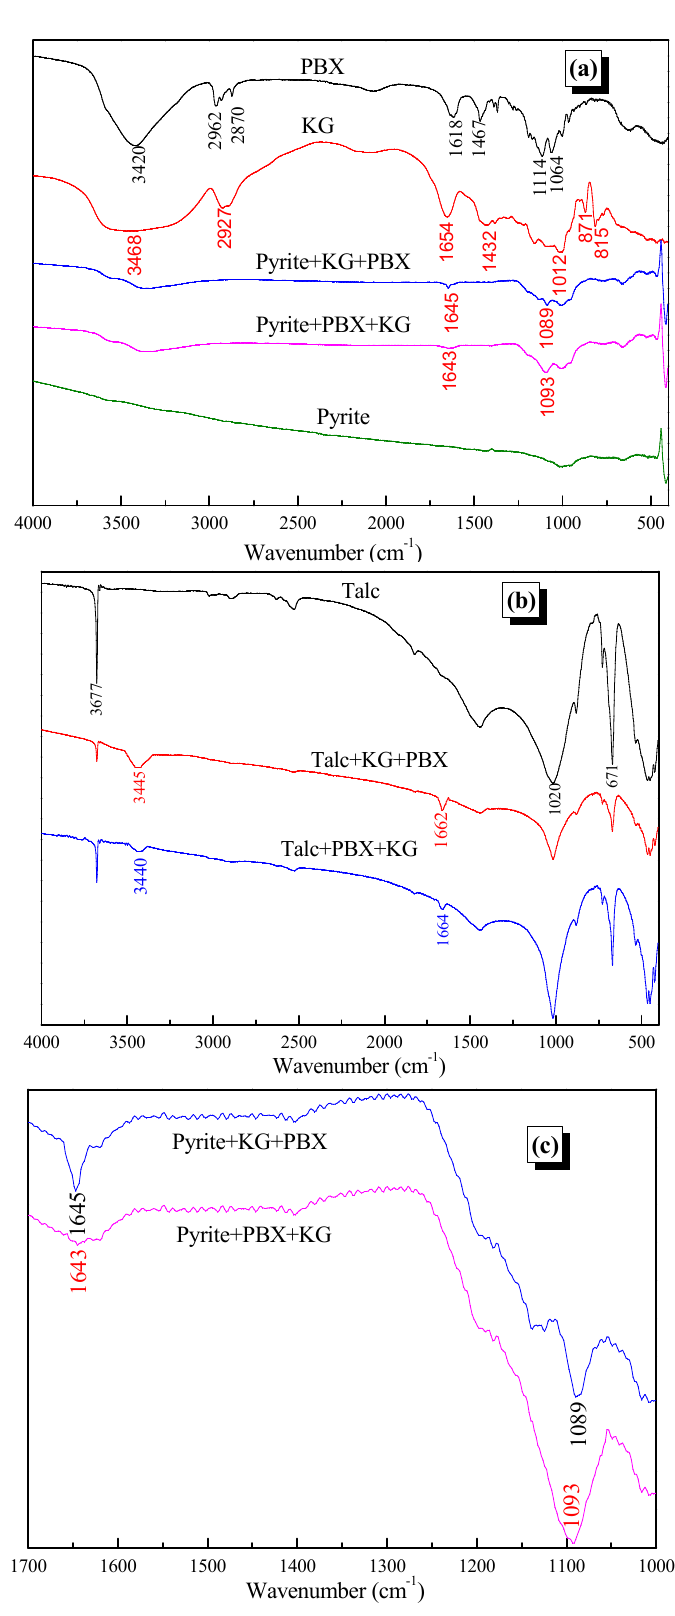
Figure 10. Infrared spectra of pyrite ( a ) and talc ( b ) after they are conditioned with reagents that are added in different order; ( c ) is the enlarged spectra of ( a